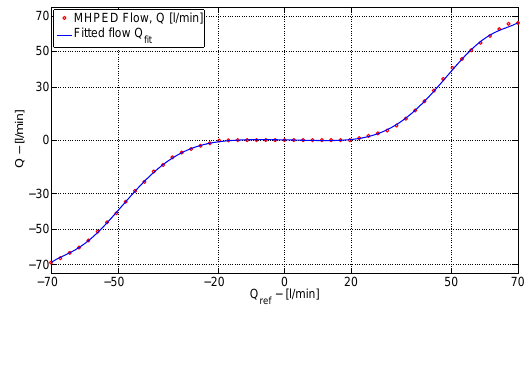
Figure 6: Flow characteristics.